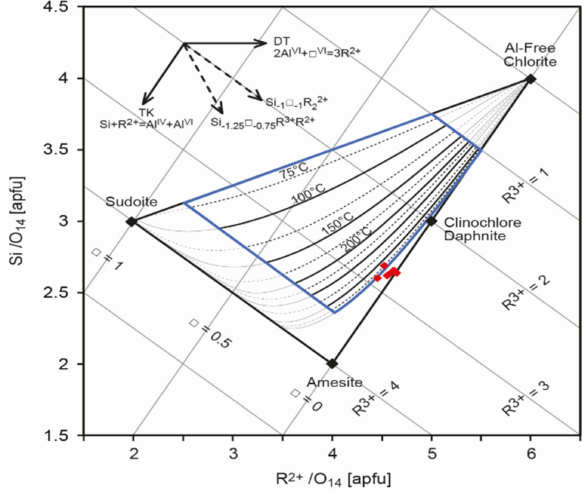
Figure 6. Chemical compositions of Fe,Mn-chlorite plotted in the R 2+ -Si diagram [61]. Temperature estimation after Bourdelle